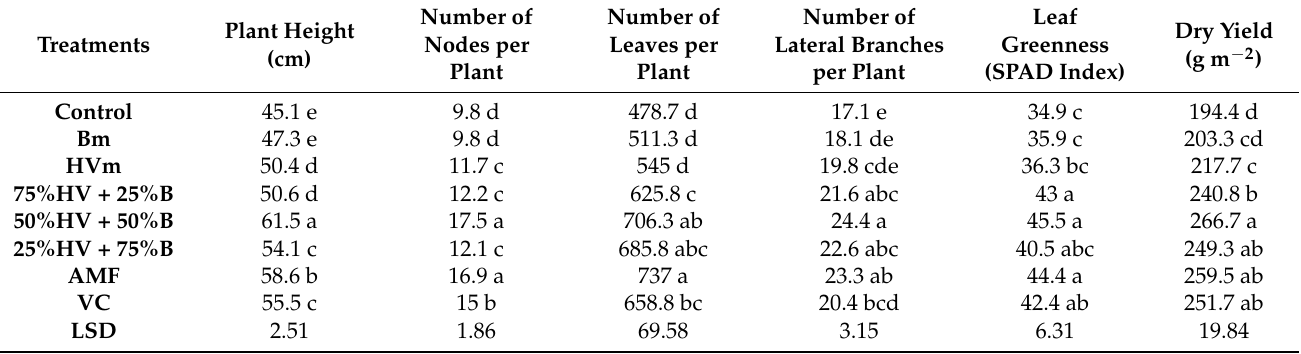
Table 1. The agronomic characteristics, leaf greenness, dry yield, essential oil content and essential oil yield of peppermint under different fertilizer sources (Average of two years).